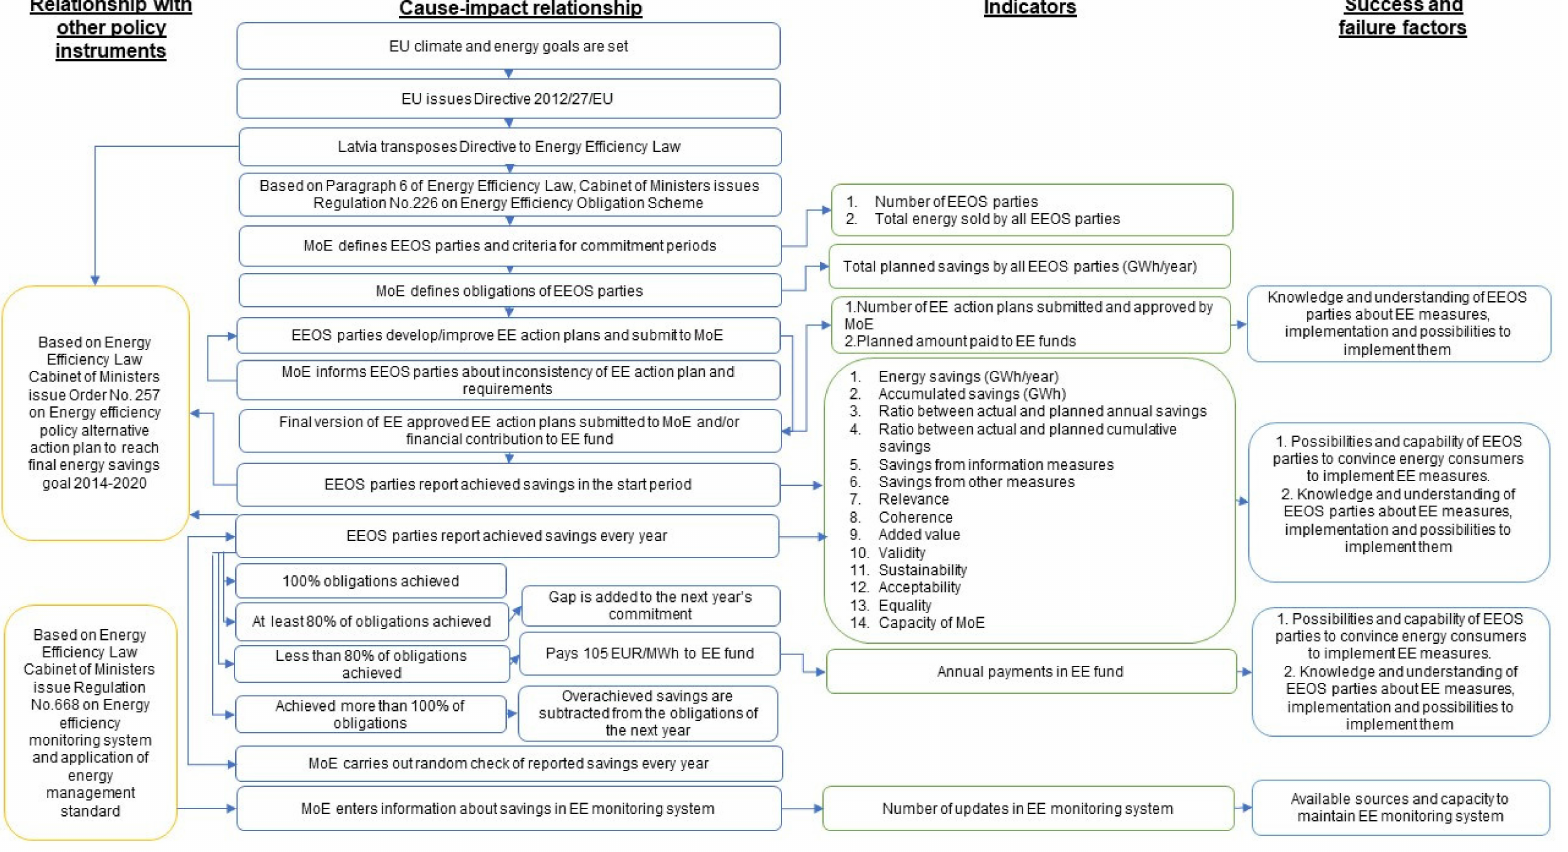
Figure 2. Theory-based policy analysis flowchart for the implementation of EEOS (MoE—Ministry of Economics, EE—energy efficiency, EEOS—energy efficiency obligation